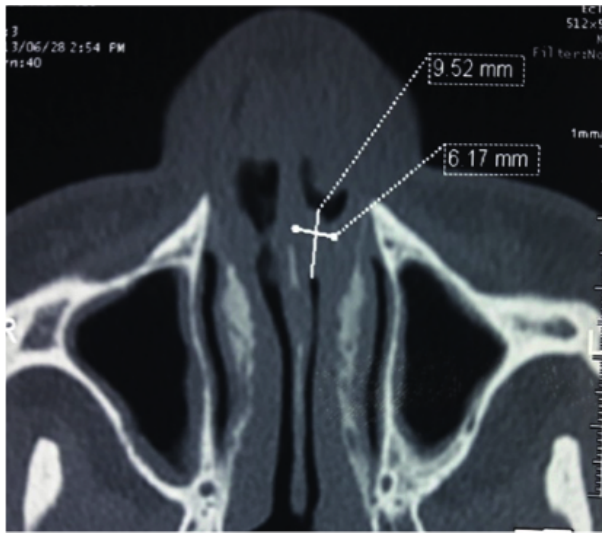
Figure 5. Tissue mass filling the nasal vestibule (case